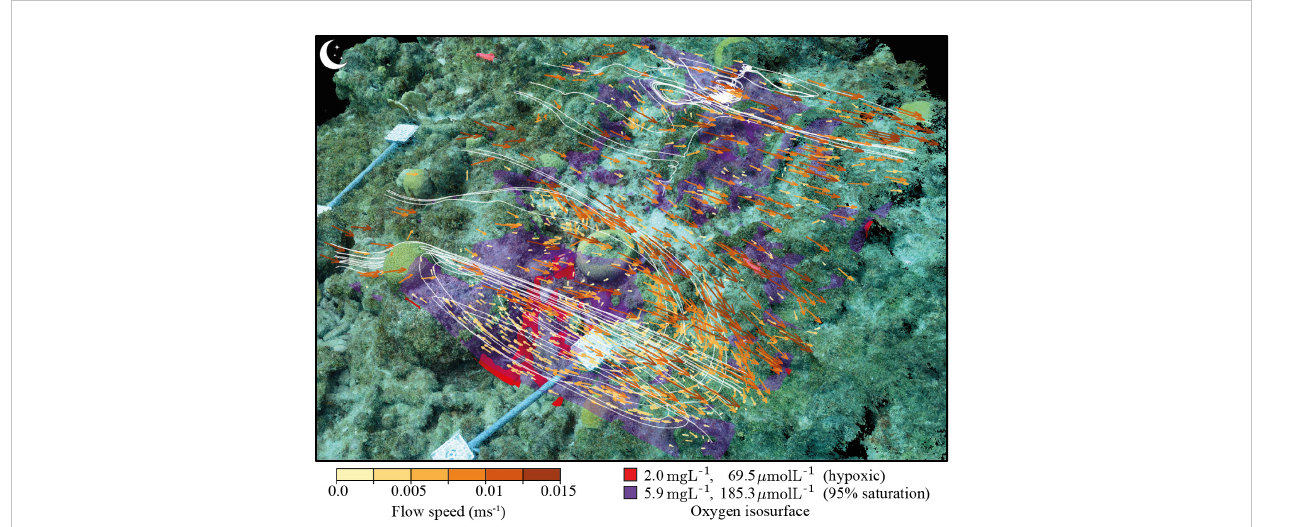
FIGURE 4 Calculated fl ow vectors across the imaged reef plot colored by speed. The red and purple areas identify isosurfaces where DO concentrations are at 95% saturation (purple, 185.3 µmol L -1 ) and below the hypoxia threshold (red, 69.5 µmol L -1 ). To give an indication of example fl ow paths, a Runge- Kutta particle tracking algorithm was implemented to track water parcels as they move over and in the reef plot. The smaller-scale features resolved in the model can be seen further in the two zoomed-in sections of the above visualization provided in Figure